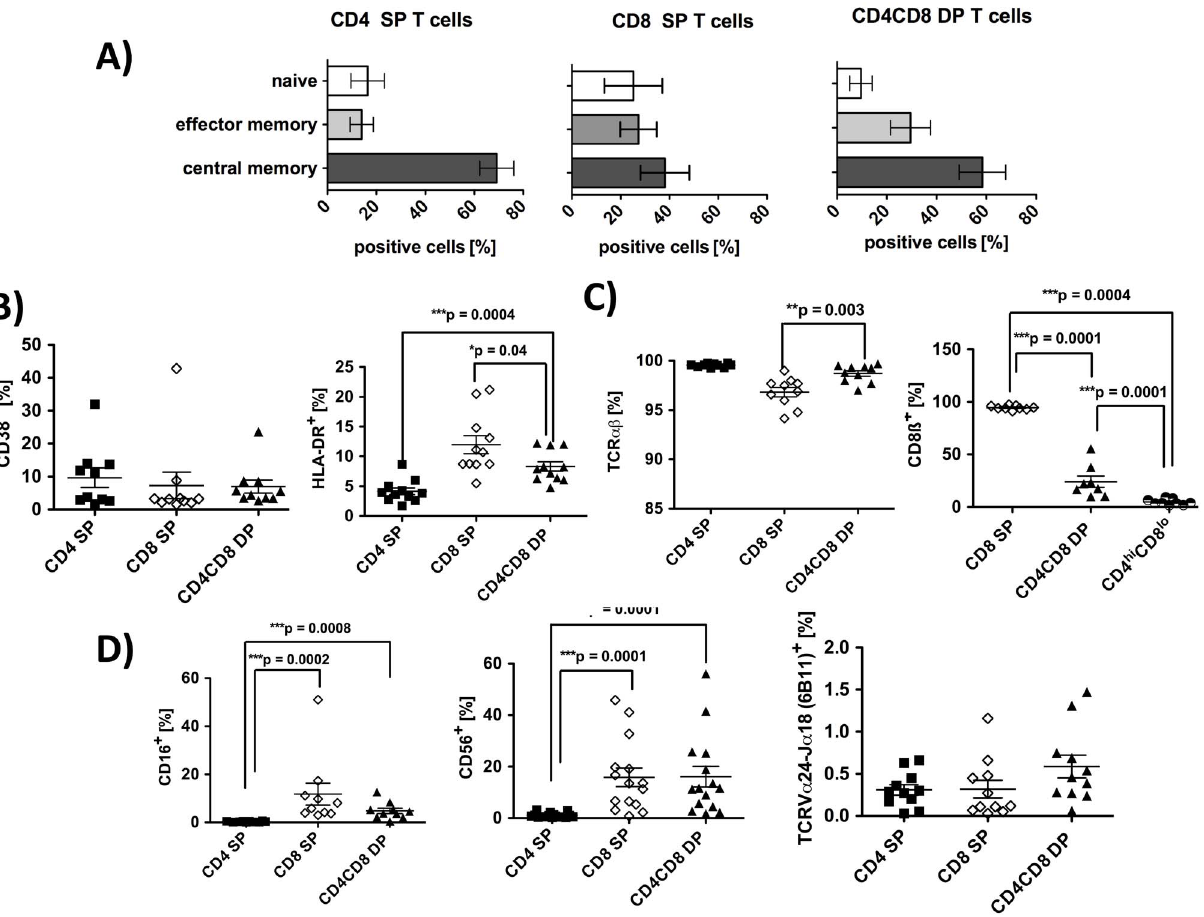
Figure 2. Phenotypic characterization of CD4CD8 DP T cells in RA patients. PBMC from RA patients were isolated and FACS analyses from live cells were performed (PI staining used for exclusion of dead cells). CD3 pregated cells were further gated on CD4 single, CD8 single and on CD4CD8 double positive T cells. A) Distribution of CD45RO 2 CCR7 + (naive) CD45RO + CCR7 2 (effector memory) and CD45RO + CCR7 + (central memory) cells in the cell populations indicated. n=5 5 B) Percentage of T cells positive for CD38 (n=10) and HLA-DR (n=11). C) Percentage of cells bearing a TCR alpha-beta (n=10) and cells positive for CD8 b (n=9) in the T cell populations indicated. ( D) Percentage of cells positive for CD16 (n=10), CD56 (n=15) and for TCRV a 24-J a 18 (n=11, marker for iNKT) in the T cell populations indicated. In all graphs, lines represent means and SEM. Significance as given, *p , 0.05, **p , 0.01, ***p , 0.001.